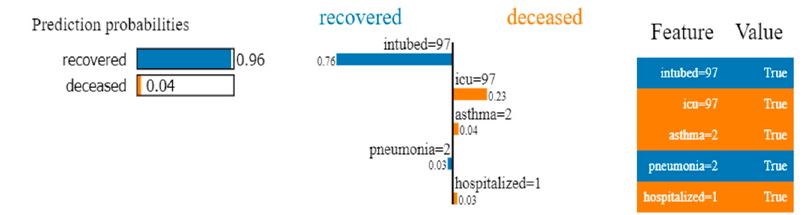
Figure 4. Explanation generated by LIME for one instance, indicating a higher probability of recovery and the weights of the most impacting features for each class.